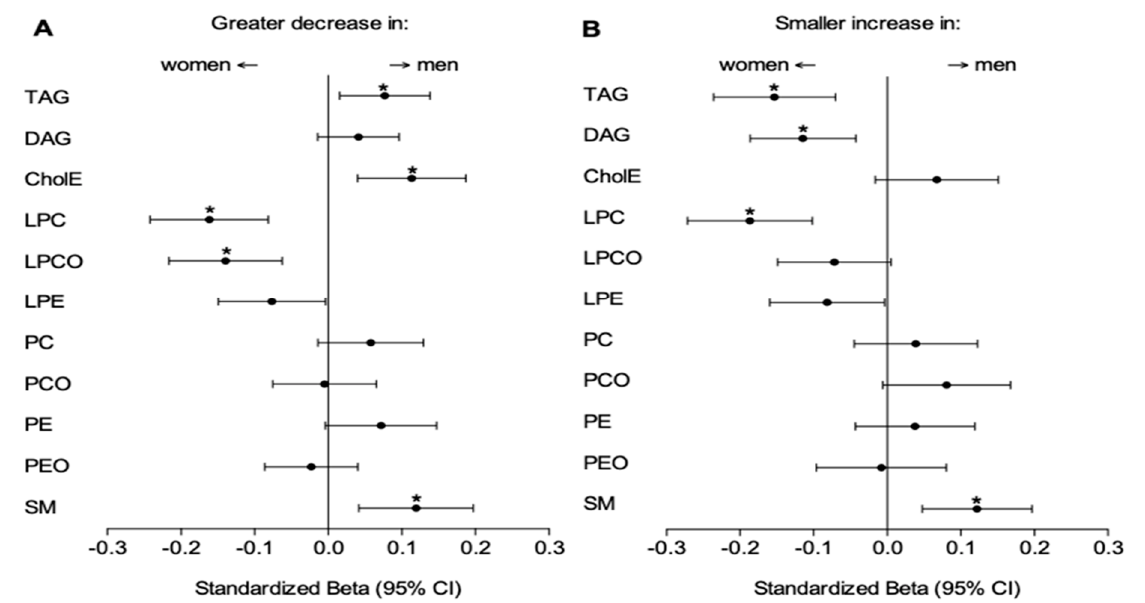
Figure 3. Standardized Beta’s ± 95% confidence interval (CI) for the association between sex and the change in lipid groups following weight loss (from CID1 to CID2) ( A ) and after 6 months of weight maintenance (from CID2 to CID3) ( B ). A negative Standardized Beta indicates a greater decrease ( A ) or smaller increase in women ( B ) compared to men and vice versa. * Indicates a significant difference in change between men and women ( q < 0.05 (=False Discovery Rate p -Value)) in a linear mixed model corrected for age, body weight (changes) and baseline